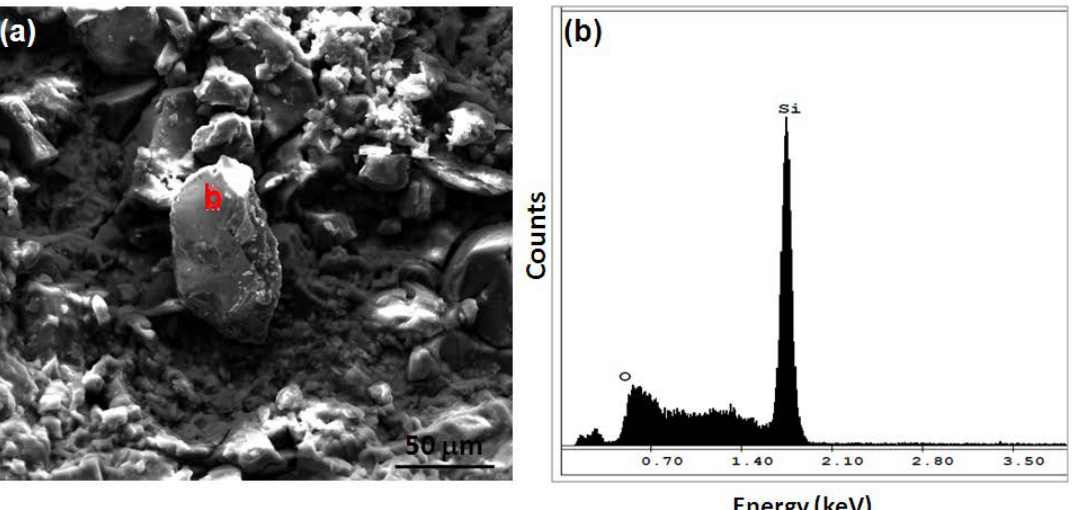
Figure 9: SE SEM image: (a) particle b in damaged portion of the antenna (location A) and (b) corresponding EDS pattern of article b.